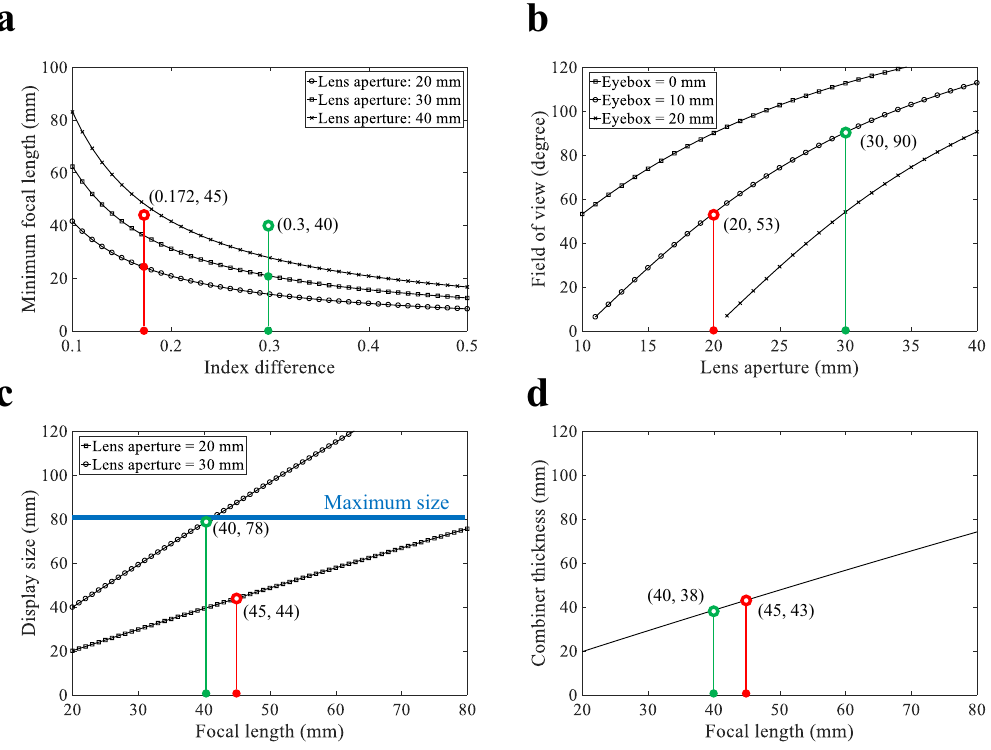
Figure 5. System performance of the AR-HMD system using IMACL: ( a ) Minimum focal length according to the index difference and lens aperture, ( b ) FOV according to the aperture size and eyebox, ( c ) required display size to have maximum FOV according to the focal length and lens aperture, and ( d ) the thickness of combiner according to the focal